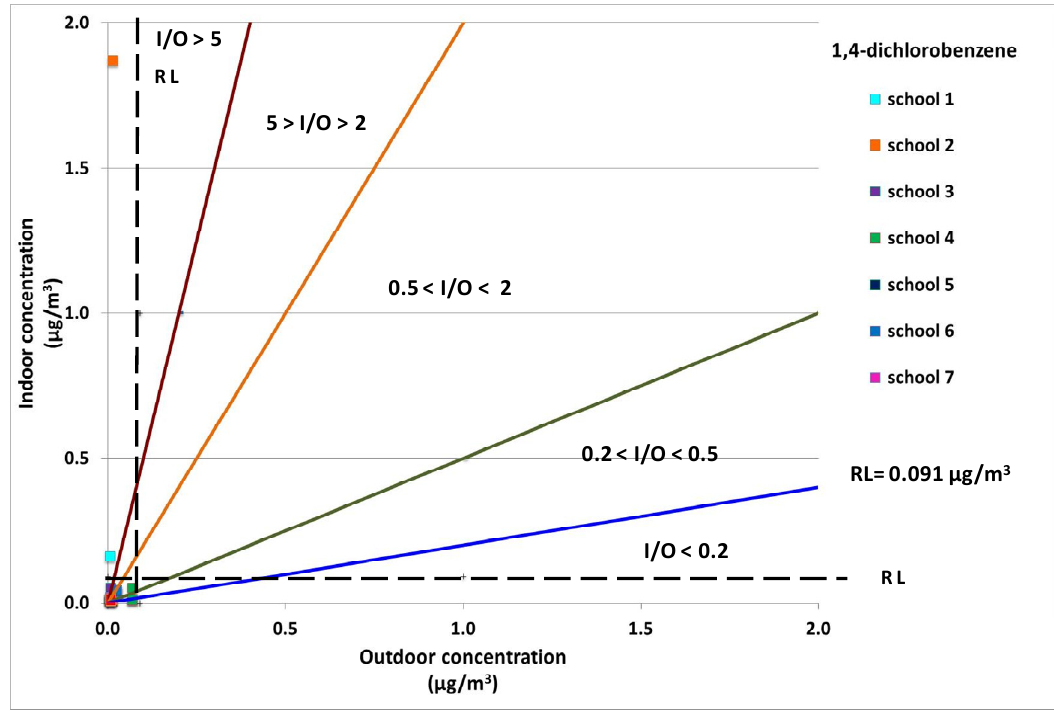
Figure 4. 1,4-Dichlorobenzene indoor concentrations against outdoor concentrations in all monitored sites. The reference level (RL) and like different I/O ranges were also